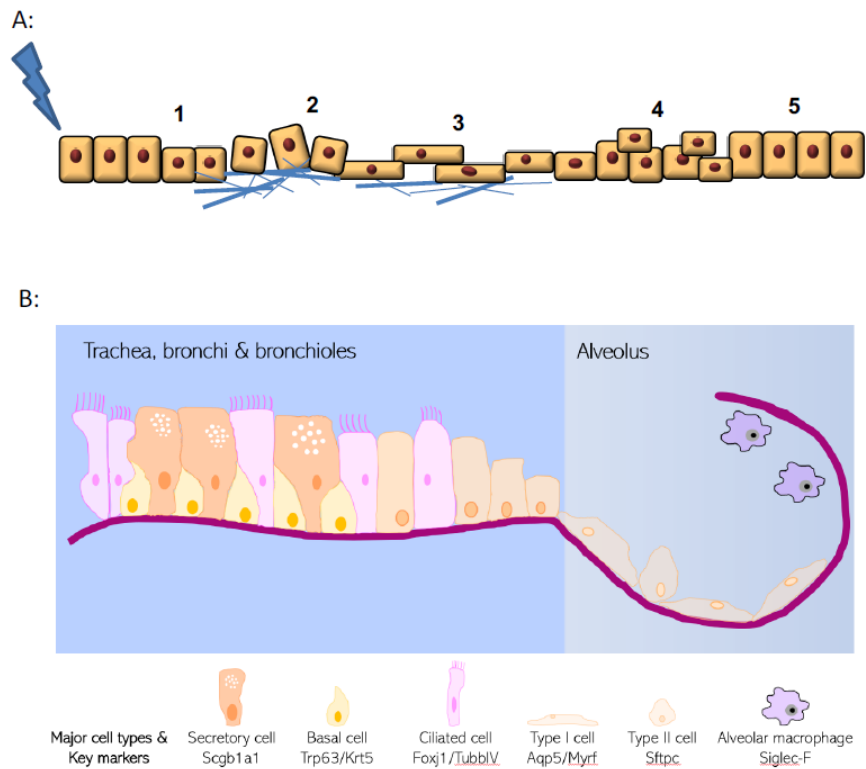
Figure 1. Hallmarks of wound healing and pulmonary epithelial organisation. ( A ) Upon injury, epithelial cells undergo a multistage process to repair damage. These phases include i. dedifferentiation from specialised and mature cells, ii. adhesion to extracellular matrix, iii. spreading and migration towards the wound site, iv. cellular proliferation and finally v. redifferentiation and repair. ( B ) Structure of the pulmonary epithelium and organisation of major epithelial cell types.